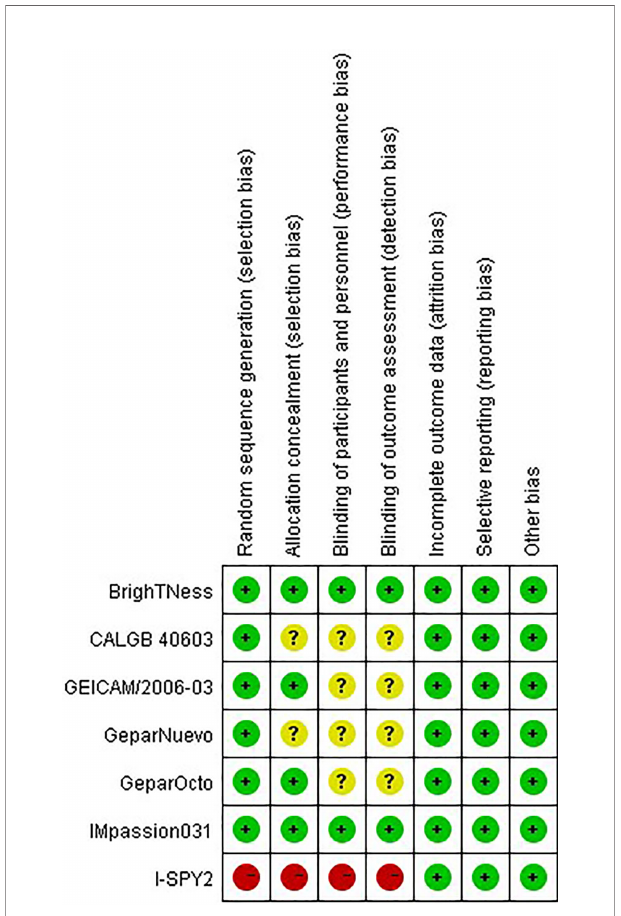
FIGURE 2 | Quality assessment for risk of bias for the included randomized controlled